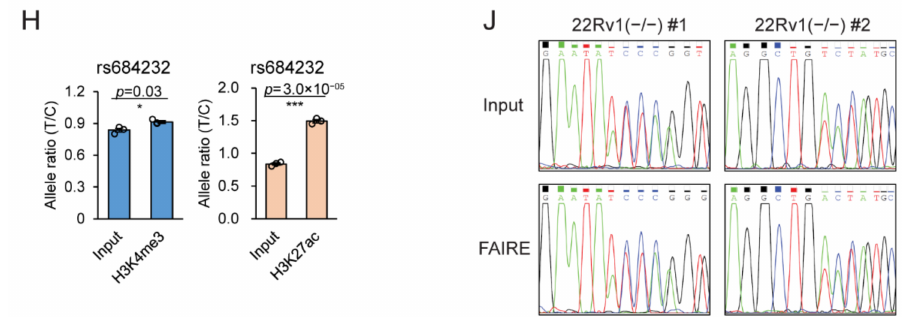
Figure 3. Chromatin status of the functional SNP rs684232 in 22Rv1 cells. ( A ) Reporter gene expression level for rs684232 SNP region in the DiR-seq analysis in 22Rv1 cells. T allele showed increased enhancer activity relative to the C allele. Mean ± SEM of three independent